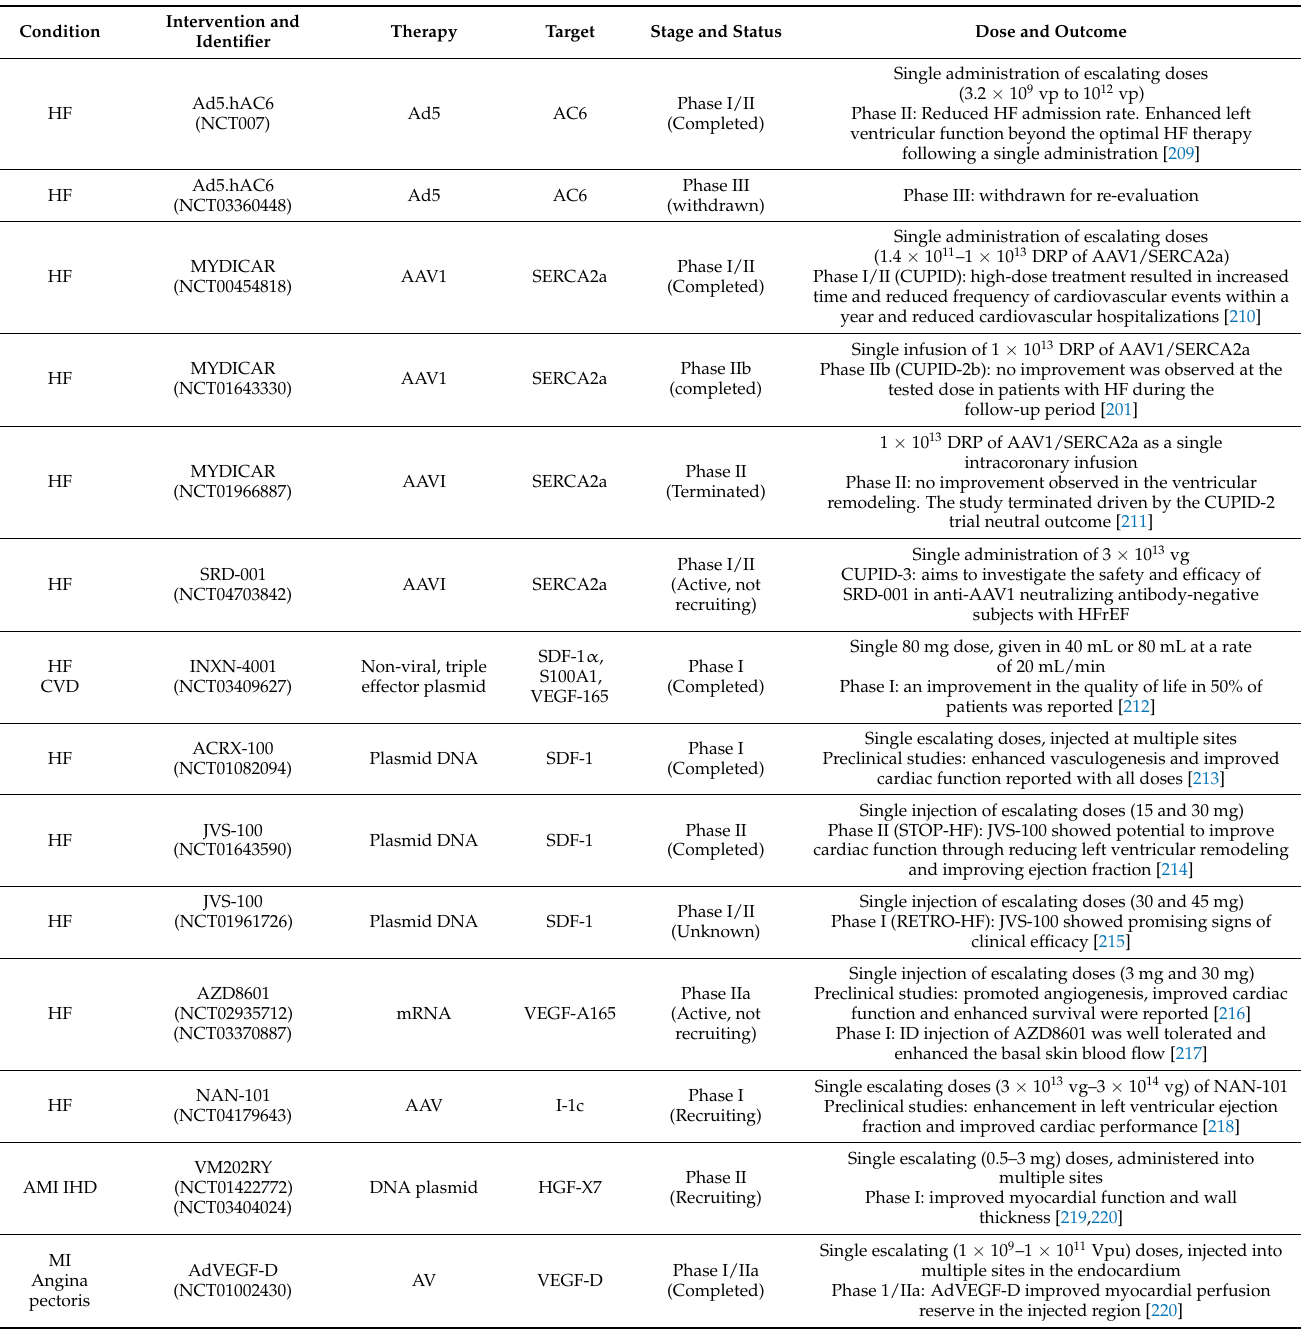
Table 5. Use of intramyocardial injections in several therapies targeting